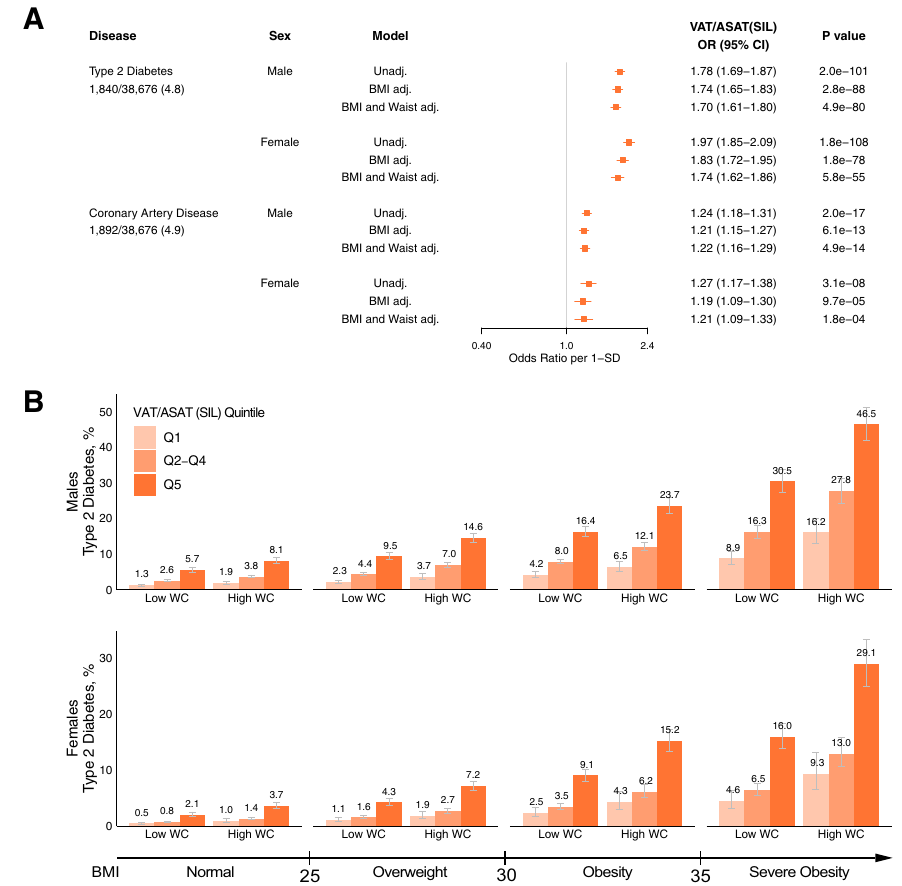
Fig. 4 Association of silhouette-predicted VAT/ASAT ratio with type 2 diabetes and coronary artery disease. A Disease associations with silhouette-predicted VAT/ASAT ratio in sex-speci fi c unadjusted and adjusted logistic regression models. All models were adjusted for age at the time of imaging and imaging center —“ BMI adj ” refers to additional adjustment for BMI, while “ BMI and Waist adj. ” refers to additional adjustment for BMI and waist circumference. Full data are available in Supplementary Data 9. B Sex-strati fi ed standardized prevalence of type 2 diabetes across the bottom quintile (light orange), quintiles 2 – 4 (neutral orange), and the top quintile (dark orange) of silhouette-predicted VAT/ASAT ratio within BMI-bins and waist circumference categories. High waist circumference was de fi ned in a sex- and BMI-subgroup speci fi c fashion as described in Supplementary Data 12. Error bars represent 95% con fi dence